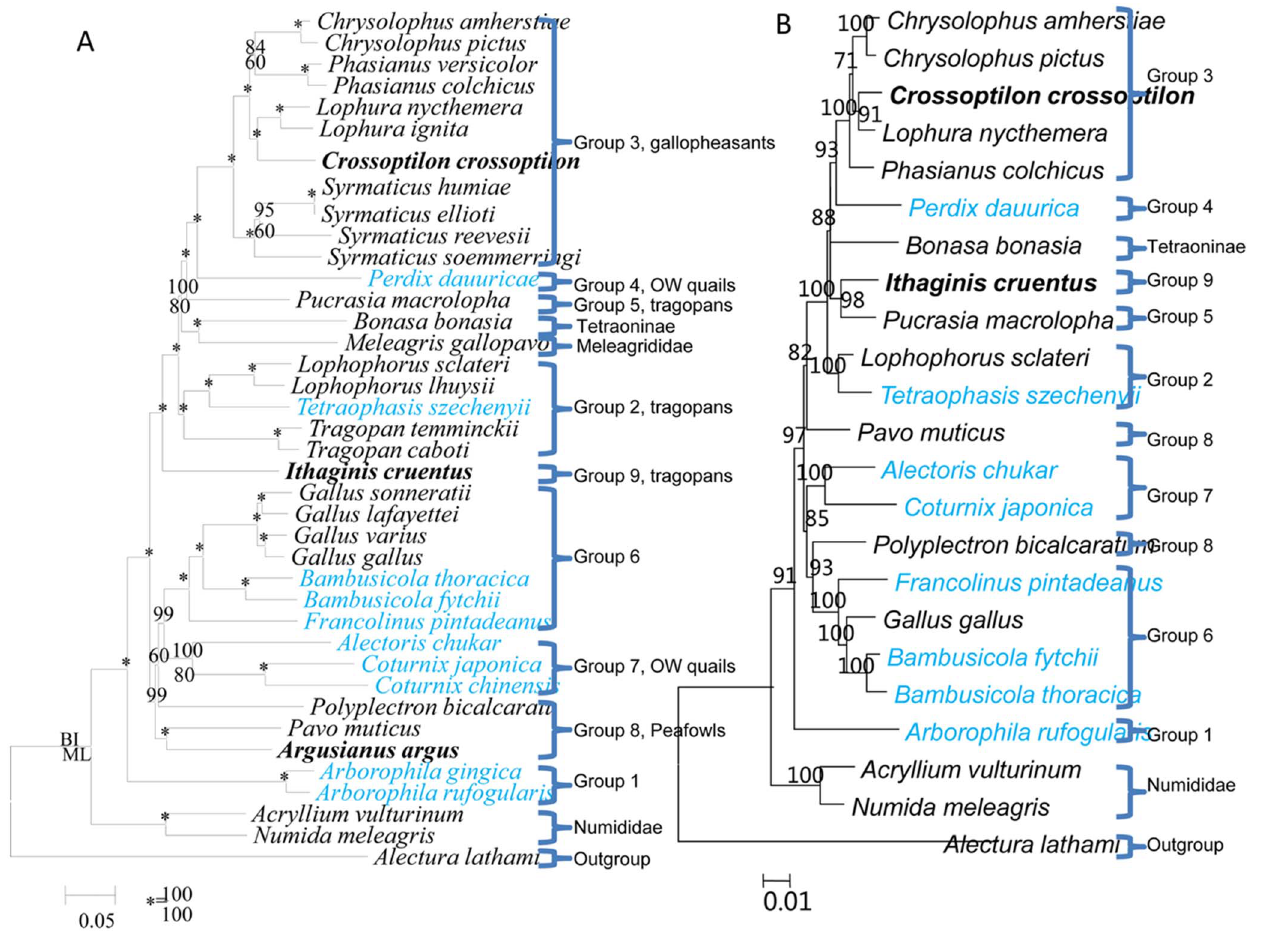
Figure 2. Phylogenetic hypotheses based on the complete mitochondrial genomes and nuclear segments for the Phasianidae. (a) Mt genomes; newly sequenced mt genomes denoted in bold. (b) Nuclear segments. Bayesian posterior probabilities . 70%, and maximum likelihood bootstrap proportions . 50% were indicated on the branches.